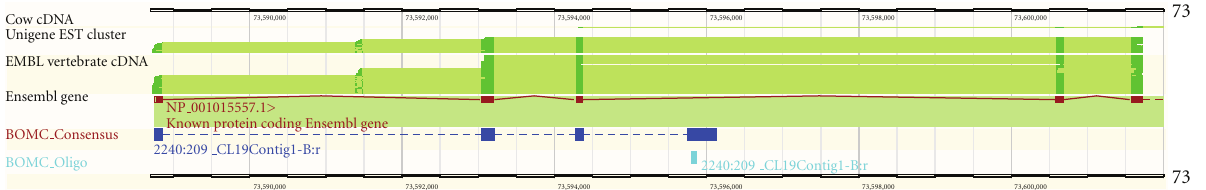
Figure 3: A portion of the HNF4a gene as displayed by the Ensembl Genome Browser. The Ensembl gene track (red) shows the Ensembl- annotated gene structure. The consensus sequence of a probe (purple track) aligns to three exons and a portion of a predicted intron. The short probe sequence (cyan track) aligns to the intron indicating that the probe detects expression of a previously unannotated splice form of the